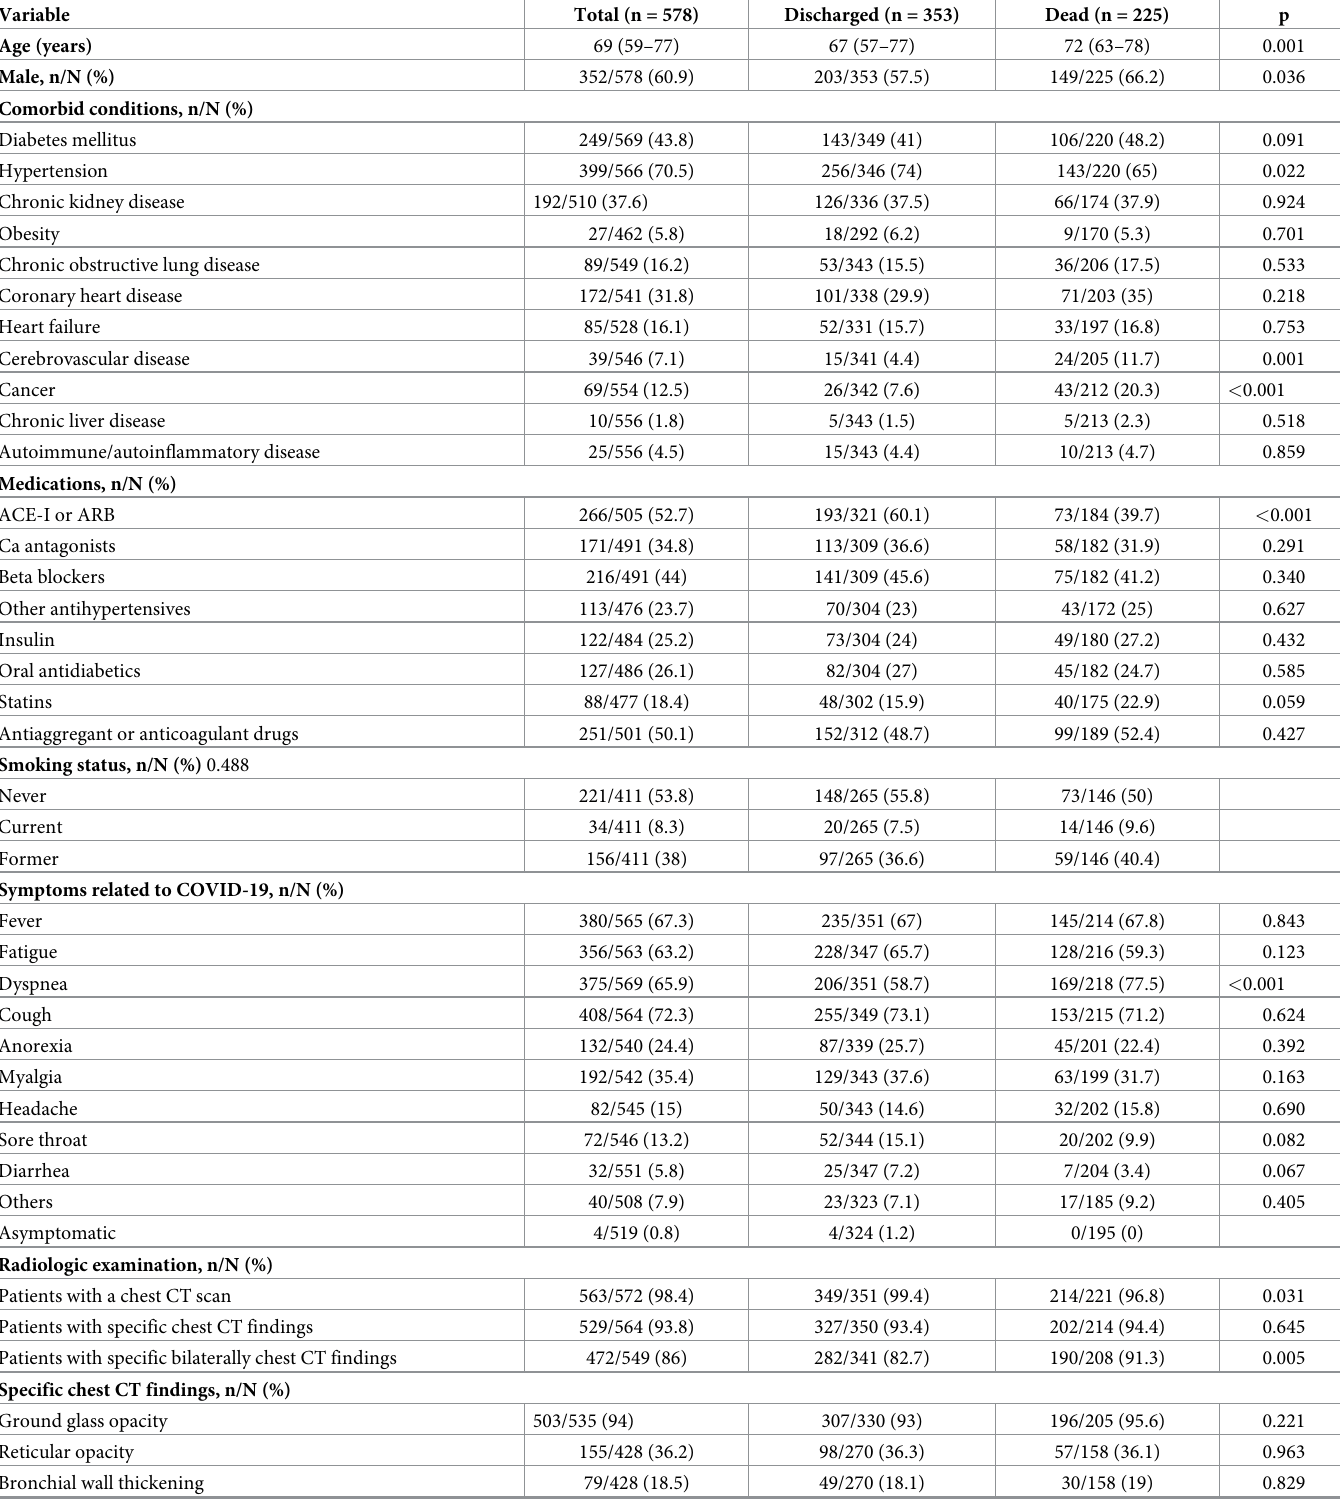
Table 3. Characteristics of COVID-19 RT-PCR positive patients based on patient